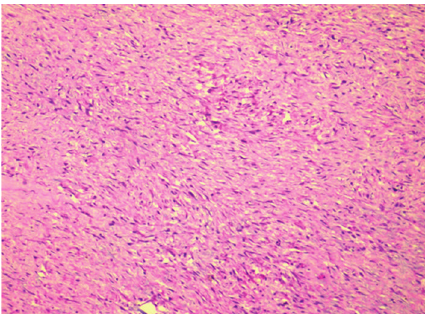
Figure 7: The individual tumour cells with pale eosinophilic cytoplasm, tapering vesicular nuclei, and inconspicuous nucleoli (40x H&E).